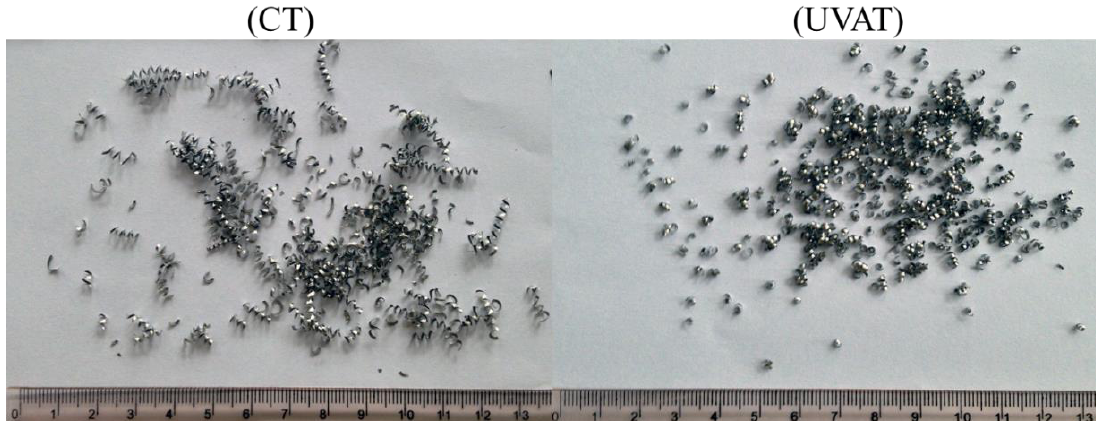
Figure 15. Chips of the studied alloy collected from the UVAT and CT processes. The CCR was calculated using Equation (2), and SA was calculated using Equation (3) for the CT and UVAT processes [47].